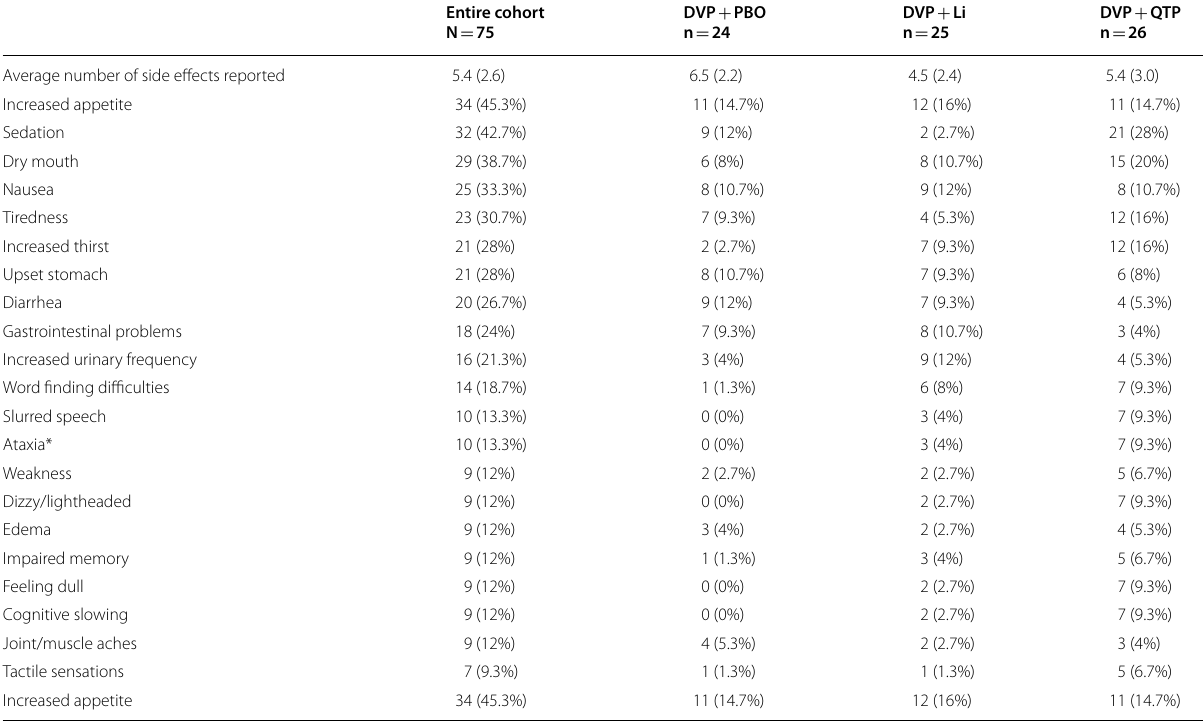
*Significant at p < 0.05 Table 4 Longitudinal outcomes in YMRS and HAM-D: monotherapy versus aggregated combination therapies